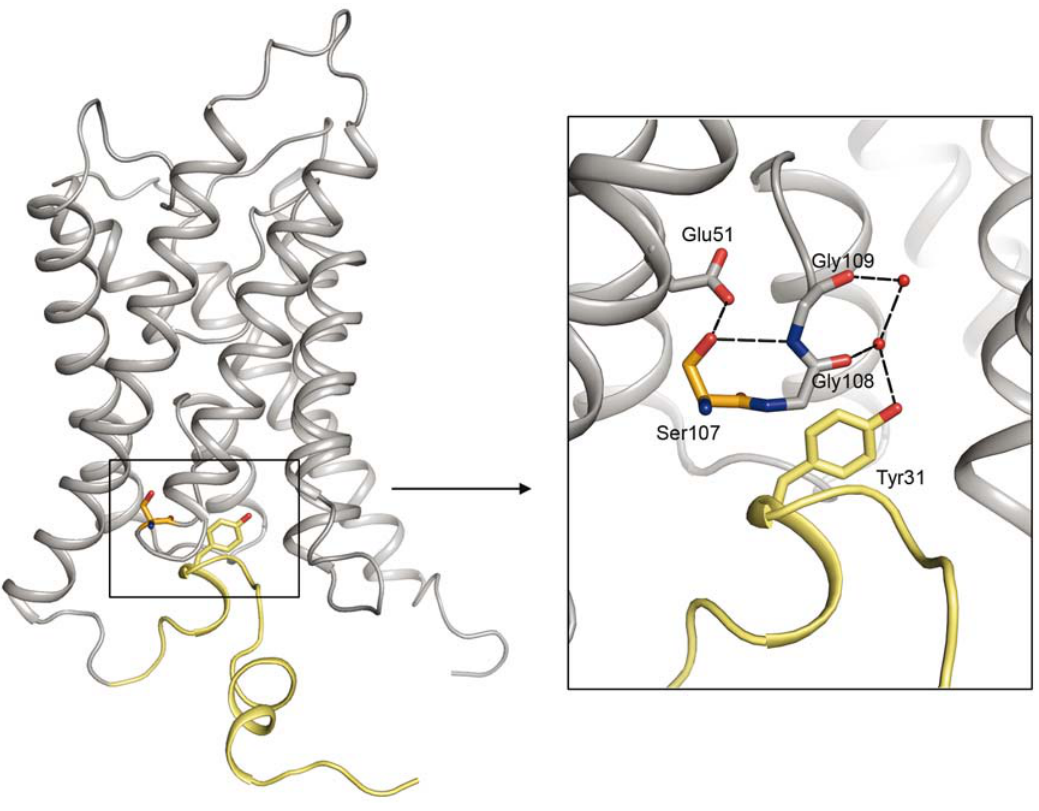
Figure 5. Putative phosphorylation site of Aqy1. Ribbon representation illustrating the location and close up view of the putative phosphorylation site Ser107. Aqy1 is shown in grey with its N terminus in yellow. The inset shows the hydrogen bond network in black.